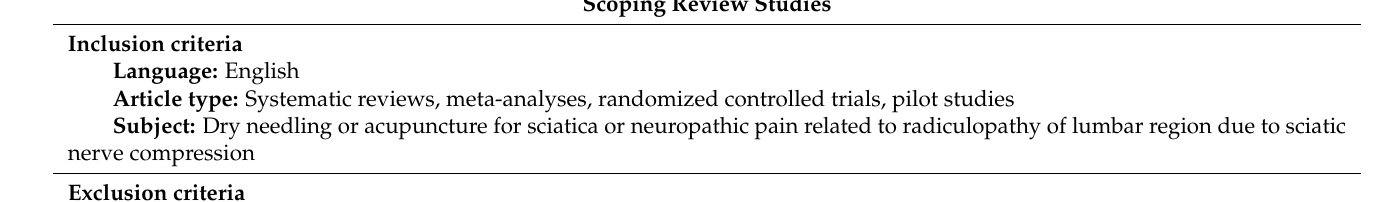
Table 2. Inclusion and exclusion